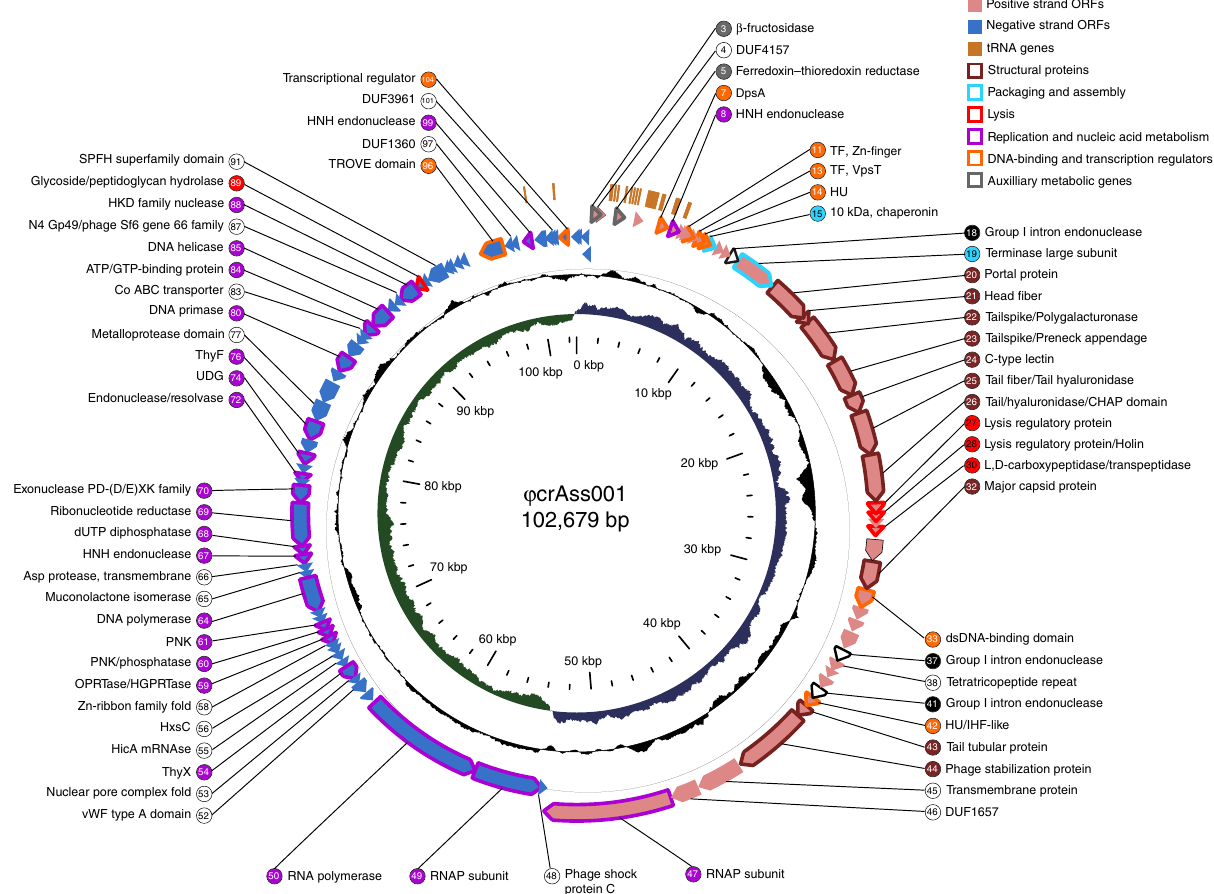
Fig. 1 Circular map of Φ crAss001 genome. Inner circle (green and blue), GC skew; middle circle (black), G + C content; outer circle (pink and purple fi ll), protein-coding genes (ORFs); outermost circle (orange fi ll), tRNA genes. Stroke colour on ORFs and fi ll colour on gene numbers corresponds with the general predicted function (see colour legend for details); black stroke, introns; genes with no functional annotations (coding for hypothetical proteins) are left